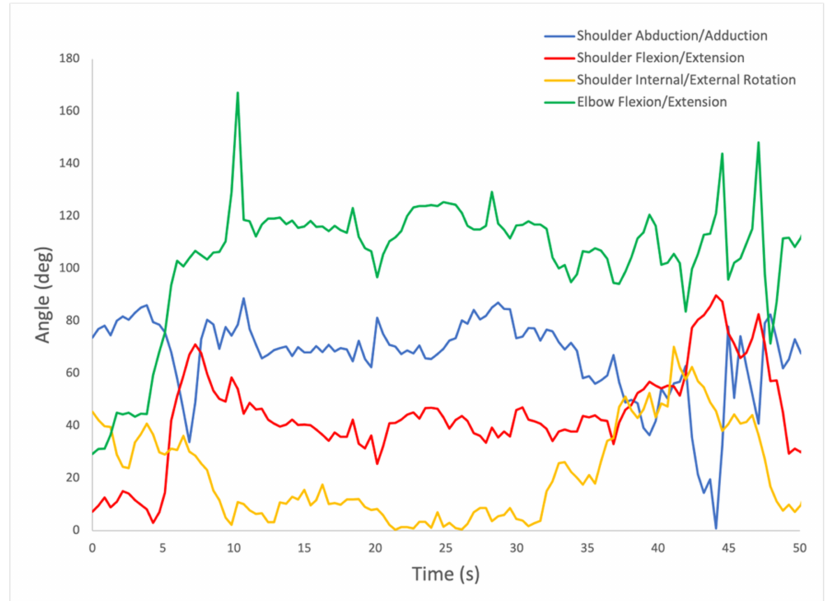
Figure 9. The upper limb joint angles as calculated by the proposed MR system during a session when one of the subjects was playing the game displayed in Figure 2a.